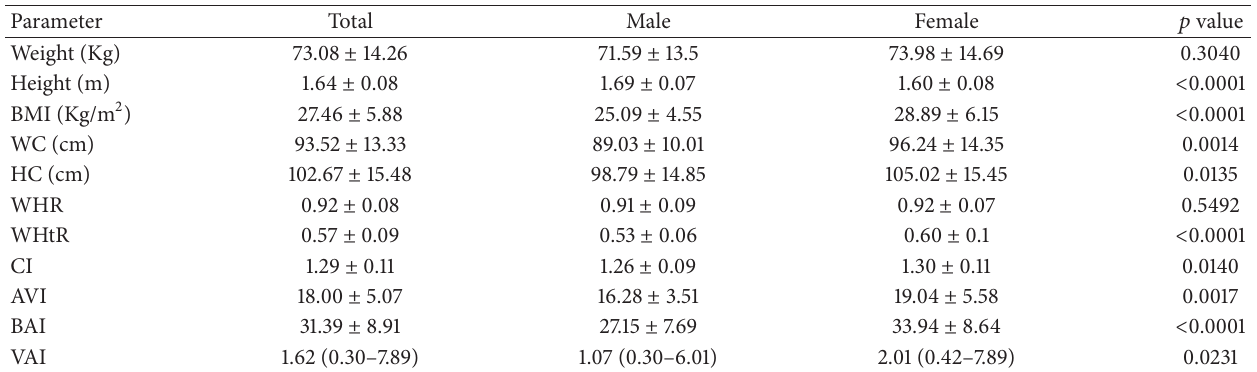
Table 2: Anthropometric parameters of patients with type 2 diabetes seeking care at the Ho Municipal Hospital stratified by gender.